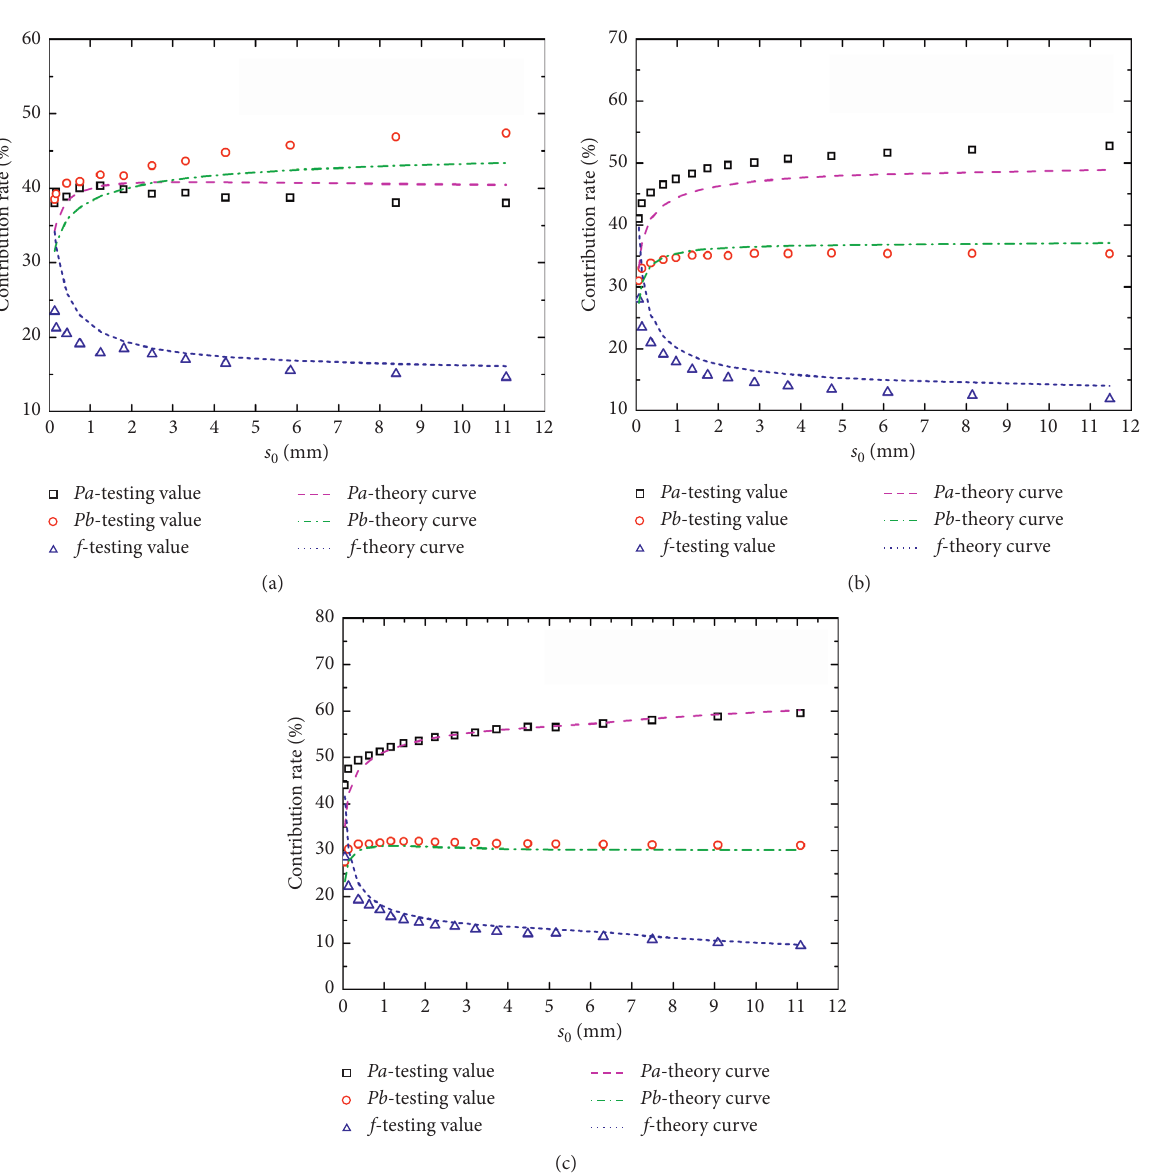
Figure 10: The comparison of the bearing capacity contribution: (a) S1, (b) S2, and (c) S3.